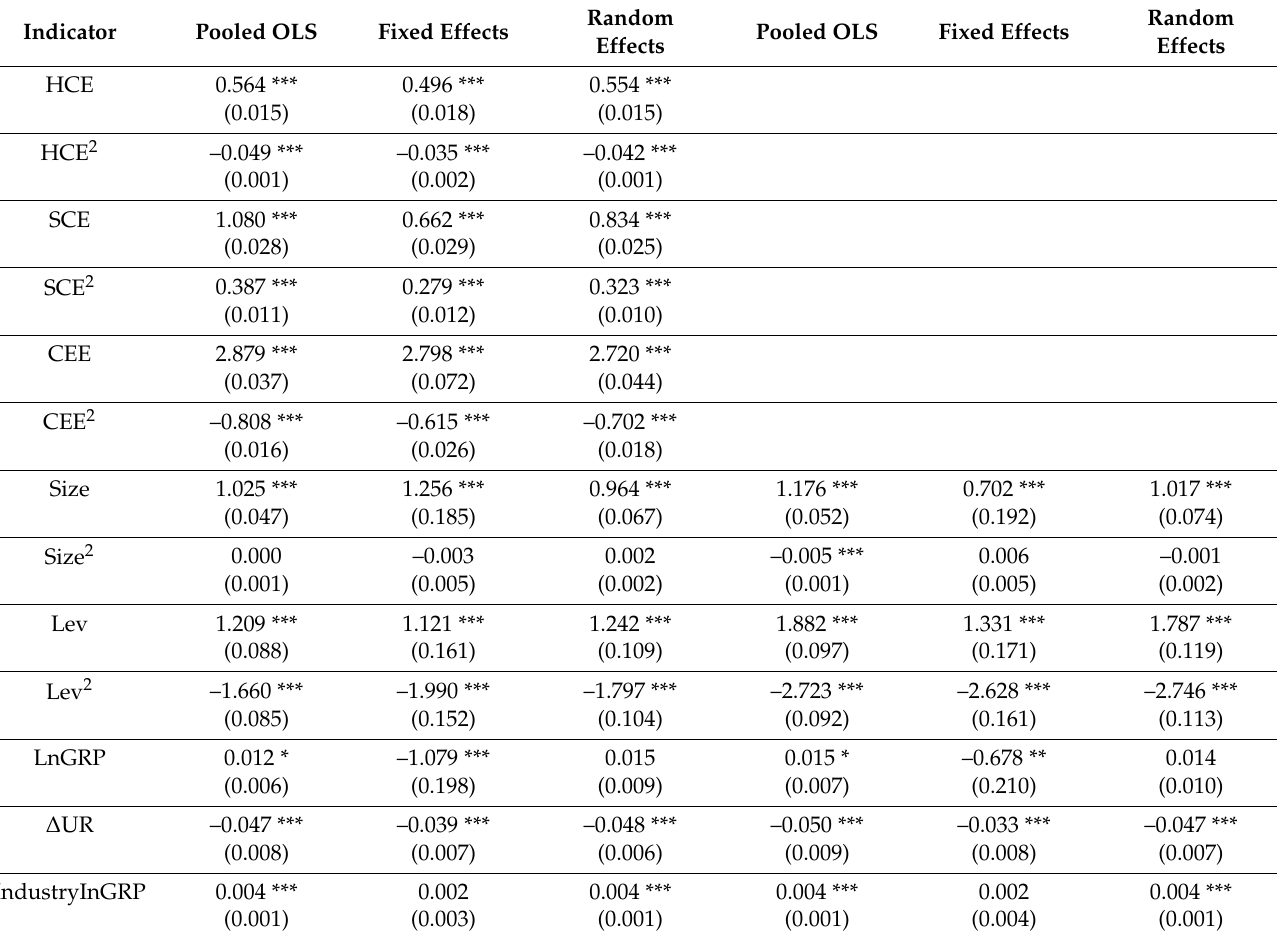
Table 3. Results of regression analysis for models with natural logarithm of EBIT as the dependent